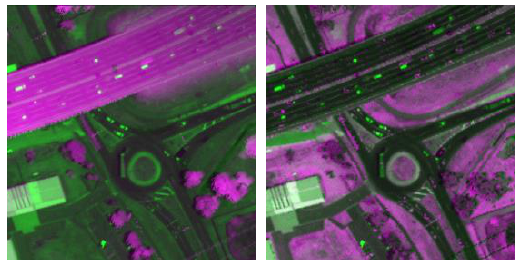
Figure 3. Satellite image (top), colour-coded LiDAR DSM (middle) and LiDAR intensity image (bottom).